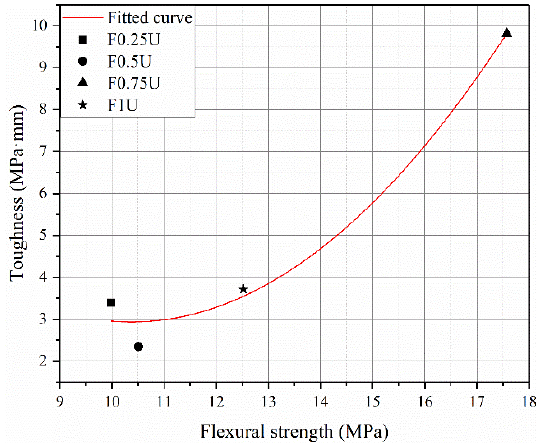
Figure 7. The relationship between flexural strength and toughness.